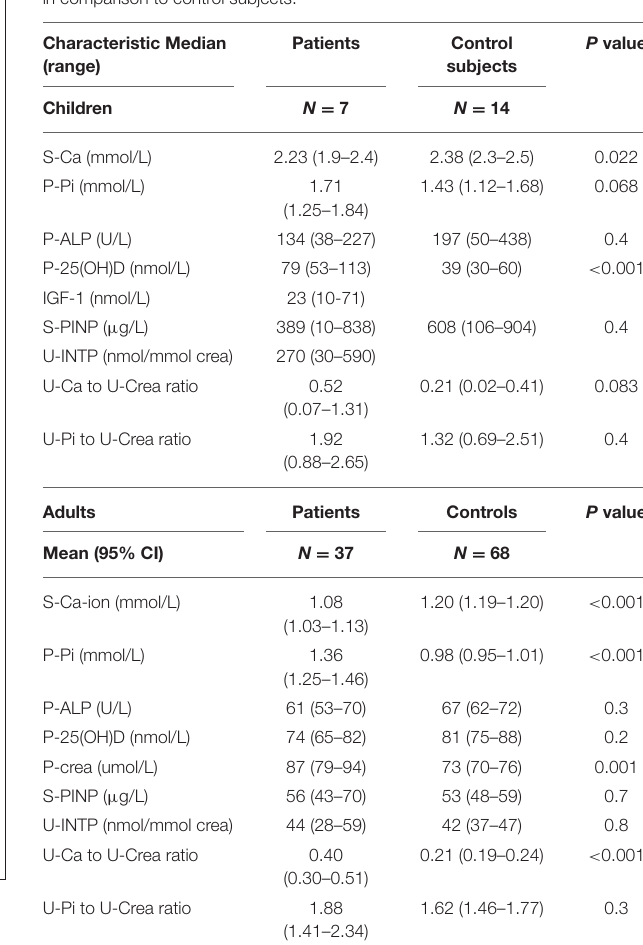
TABLE 3 | Biochemical parameters in pediatric and adult patients with APECED in comparison to control